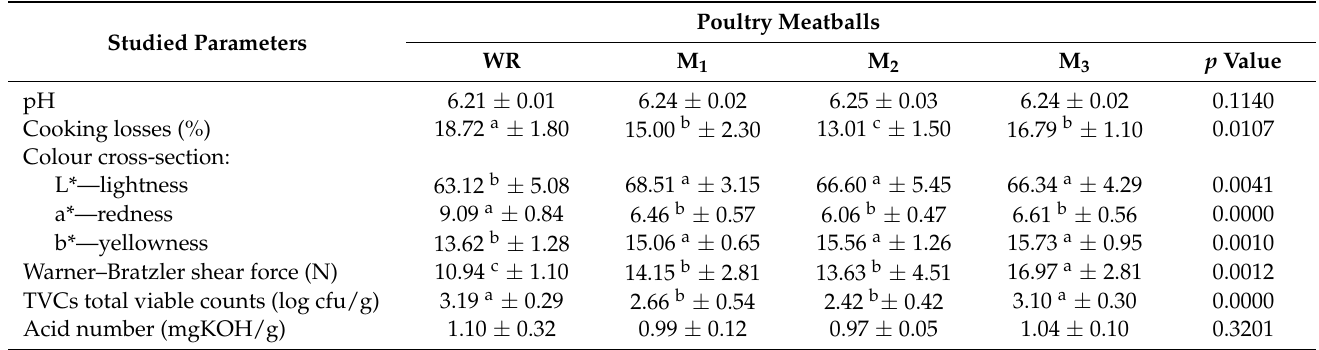
Table 2. Effect of adding a mixture of linseed, amaranth and hemp seeds on the physical characteris- tics, total number of bacteria and acid number of poultry meatballs (x ±